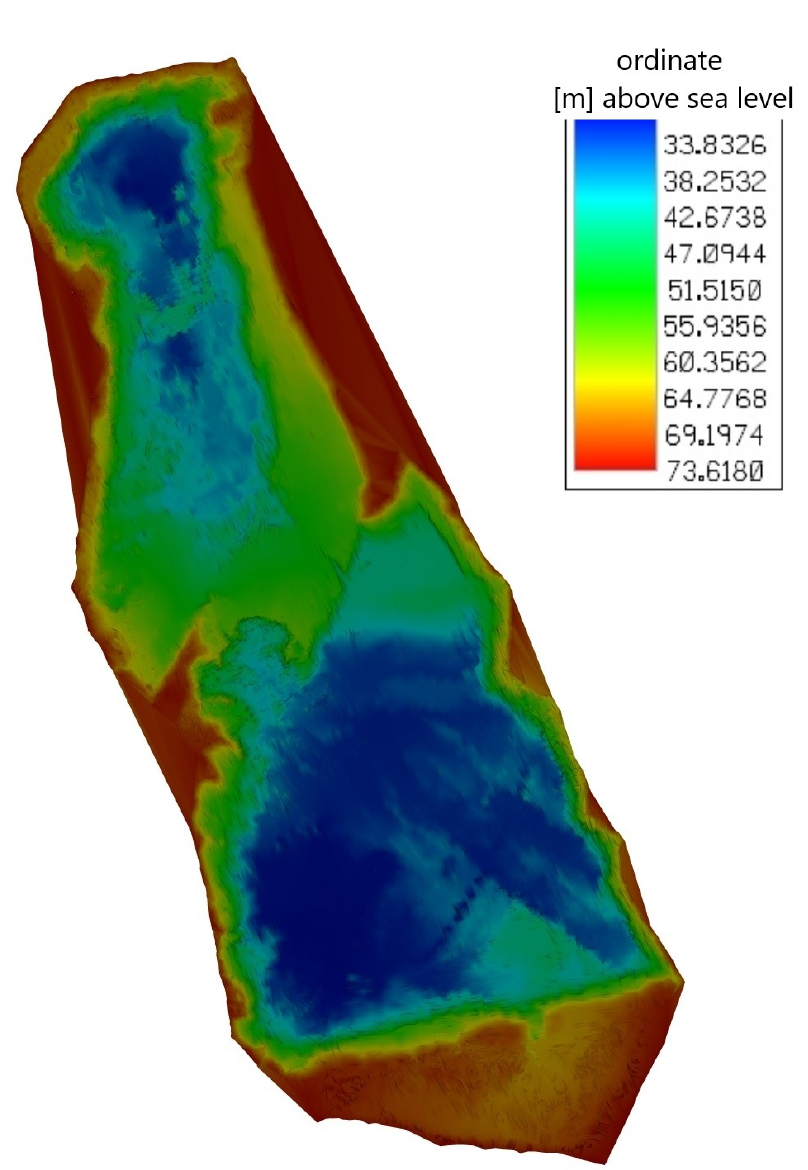
Figure 4. Three-dimensional model of the bottom and slopes of Lubstów reservoir.